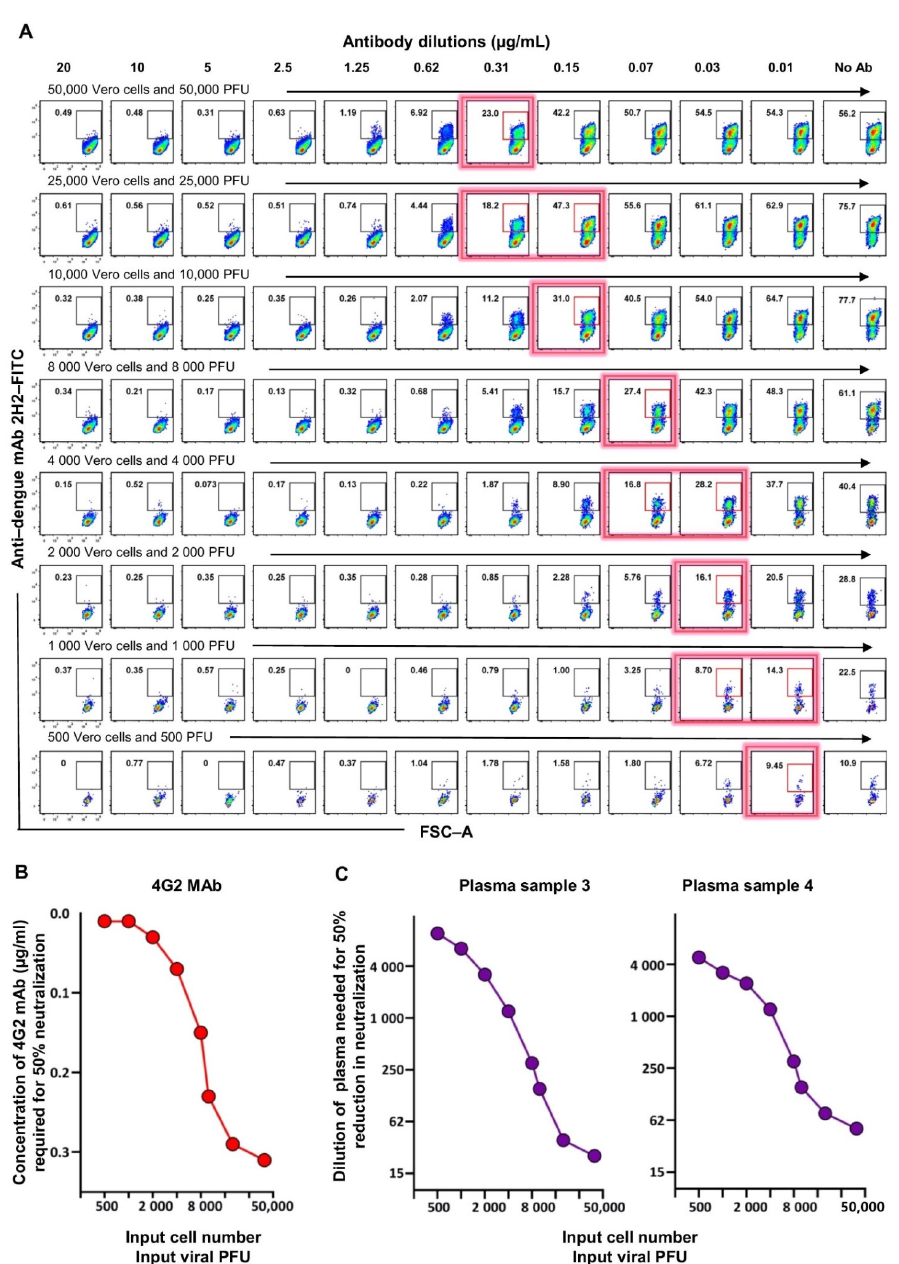
Figure 3. Optimization of the flow cytometry based neutralizing assay such that the neutralization titers obtained by this assay are in concordance with the traditional foci-based neutralizing assay. ( A ) Raw data shown are for flow cytometry staining plots for Vero cells that were seeded at the indi- cated numbers per well and then infected with the indicated PFU of DENV2 that was preincubated with titrating concentrations of 4G2 monoclonal antibody. Cells were stained 24 h post-infection using anti-dengue 2H2 monoclonal antibody. Red box and red shadow on a flow cytometry plot indicate the approximate position where 50% neutralization of virus was achieved. ( B ) Concentration of 4G2 monoclonal antibody needed to cause 50% neutralization in the flow cytometry based assay using graded number of Vero cells at an MOI of 1. ( C ) Dilution of plasma needed to cause 50% neutralization in the flow cytometry based assay using graded number of Vero cells at an MOI of 1. Two individual plasma samples are